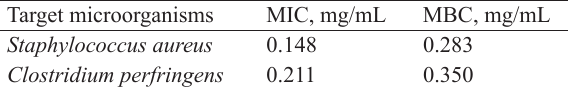
Table 3 Phenolic compounds of caper ( Capparis spinosa L.) extract